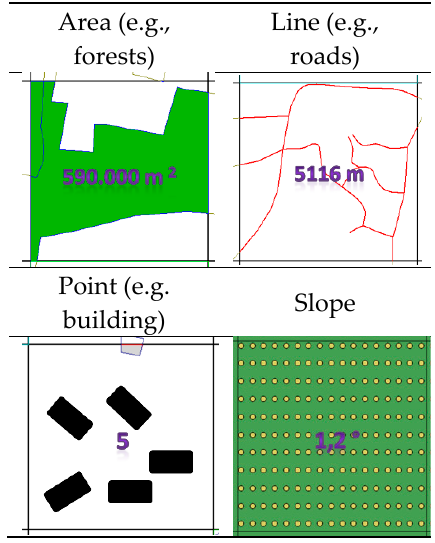
Figure 3 . Example of gathering land cover element data for a 1000 × 1000 m grid. Figure 3. Example of gathering land cover element data for a 1000 × 1000 m